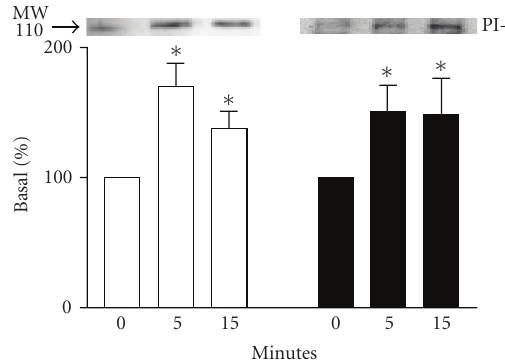
Figure 3: PI-3K Partitioning of PI-3K to the membrane . Forty- eight hours after transfection, cells were stimulated with 1 μ M isoproterenol for the indicated times. Membranes were isolated, solubilized, and approximately 100 μ g of membrane proteins were separated on a 10% SDS-PAGE gel. Membrane-associated PI-3K levels increased with cells expressing β 1 -AR ( (cid:2) ) or β 2 -AR ( (cid:3) ). Top panel is a representative immunoblot of the experiments ( n = 3-4). Data from these experiments is quantitated in the bottom panel as described in Section 2. ∗ P < . 05 versus 0 minute.